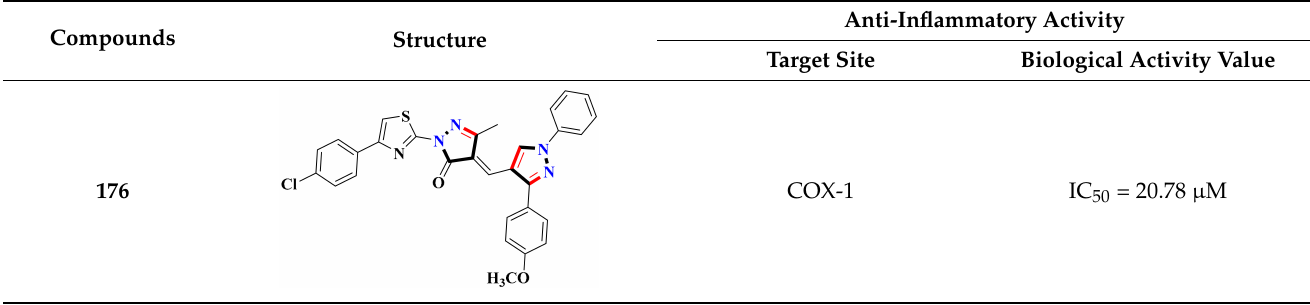
Table 13. Representative compound structures 176 to 187 and their anti-inflammatory